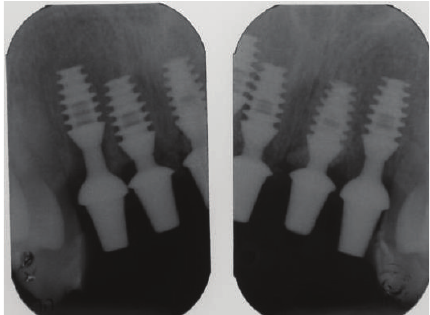
Figure 6: Postsurgical placement of Bicon implants. The implants lie 2-3mm below the alveolar crest.